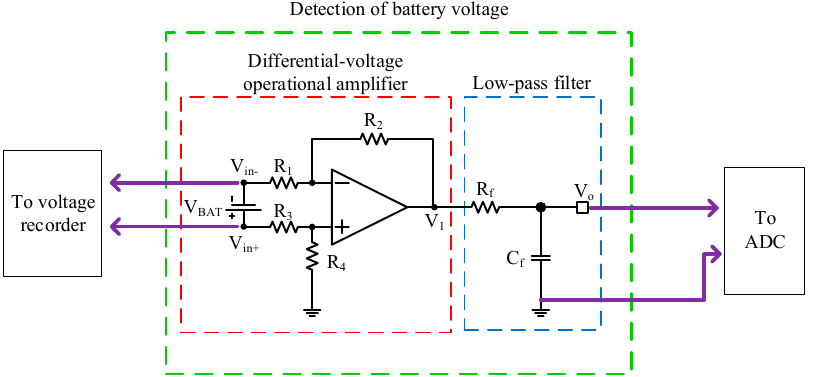
Figure 11. The detection of battery voltage circuit.